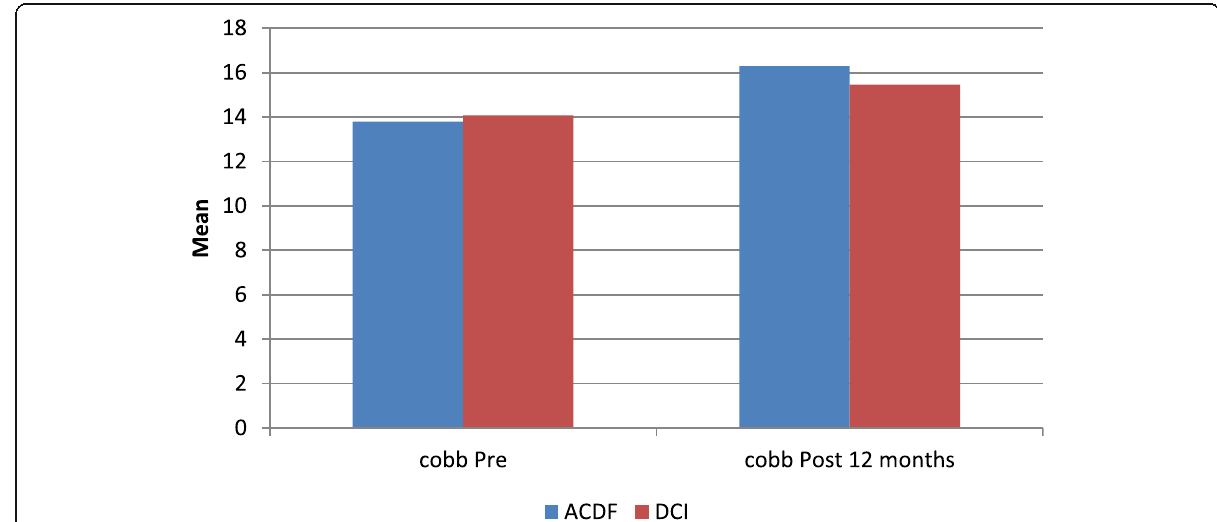
Fig. 5 Cobb ’ s angle mean value preoperatively and at 12 months postoperatively for both